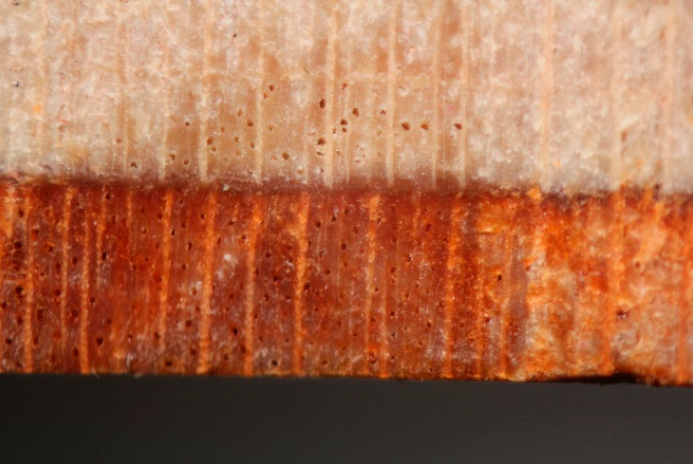
Figure 21. Species Identification Sample 1 20×.